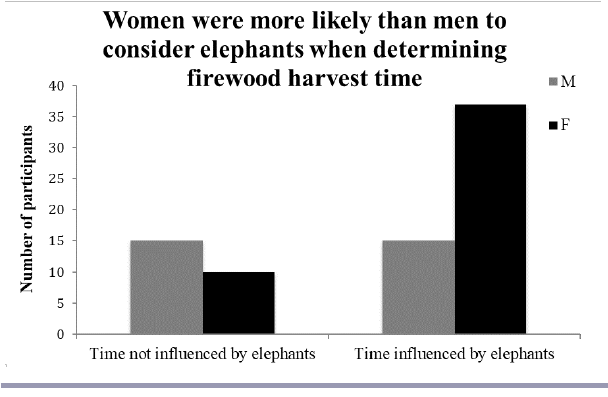
Fig. 4 . Women (F) were more likely than men (M) to account for elephant movement in deciding harvest firewood times, X² (1, N = 77) = 6.89, p = 0.0086.